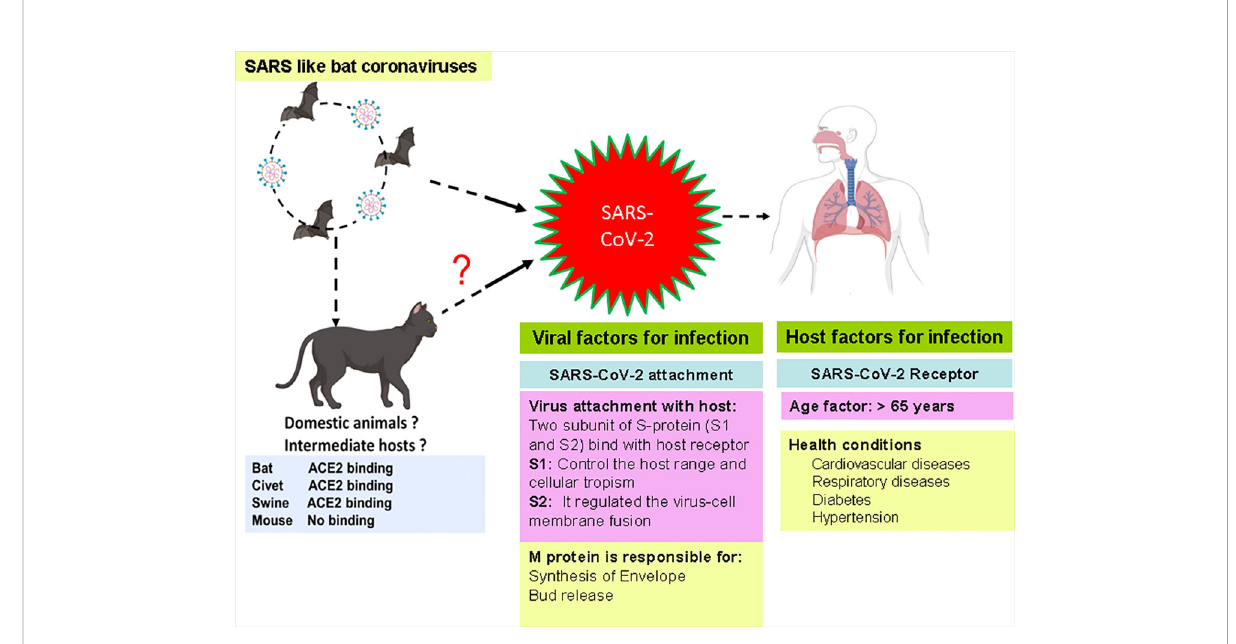
FIGURE 1 Factors connected with the infection of SARS-CoV-2 in